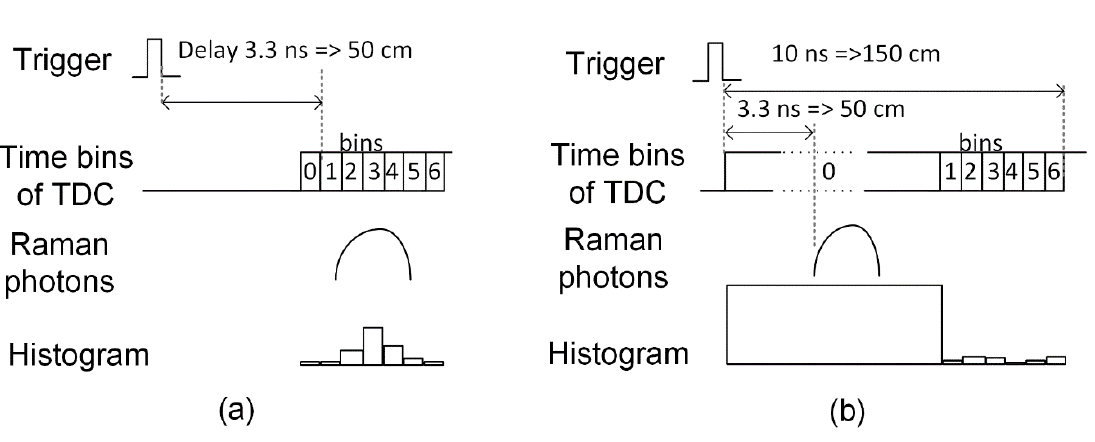
Figure 4. Time gating configurations collecting ( a ) only Raman photons from a target at 50 cm, and ( b ) all photons within a 10 ns time window.